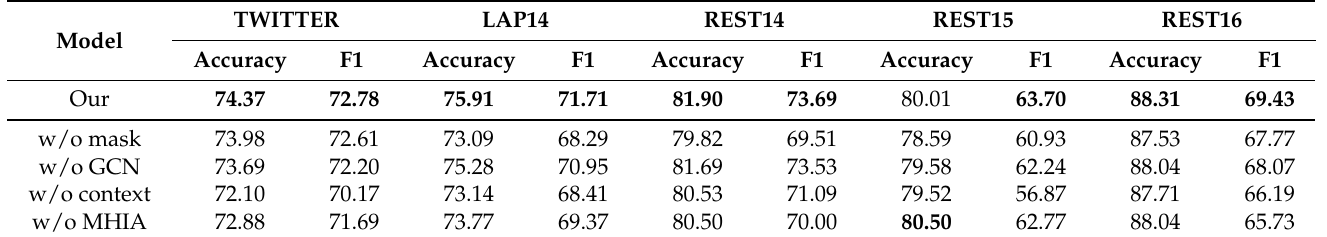
Table 3. Ablation study results (%). The best results with each dataset are highlighted in